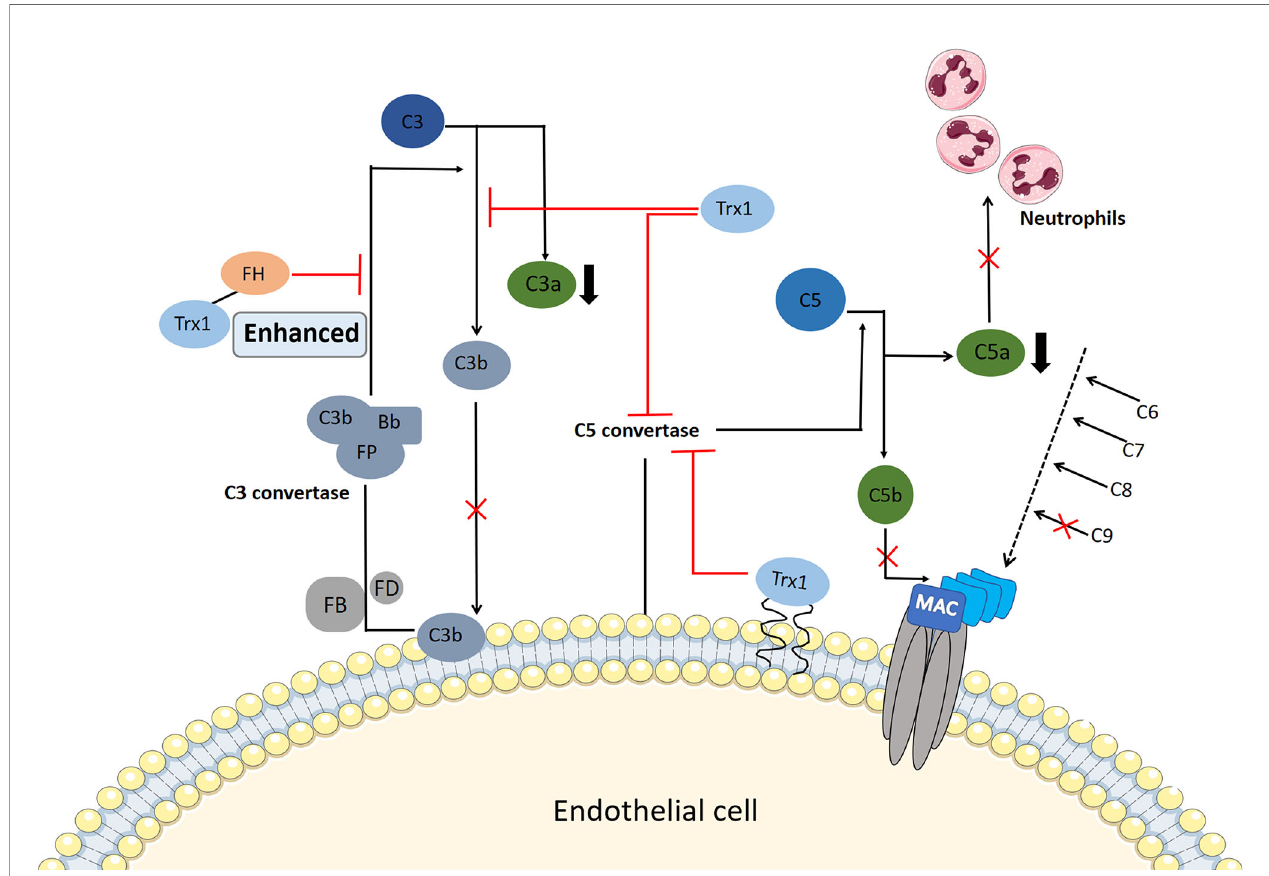
FIGURE 3 | Potential mechanism of thioredoxin-1 (Trx1) inhibition of complement activation. Serum Trx1 inhibits C3 cleavage in the alternative pathway alone and enhances factor H (FH)-induced inhibition of C3 cleavage by combining with FH, which reduces C3a levels and C3b deposition. In contrast, Trx1 on the surface of endothelial cells or serum Trx1 blocks the production and deposition of C5b by inhibiting C5 convertase activity in the three complement terminal pathways; moreover, C9 deposition is inhibited. At the same time, Trx1 inhibits the production of anaphylaxis toxin C5a, which reduces the chemotaxis of